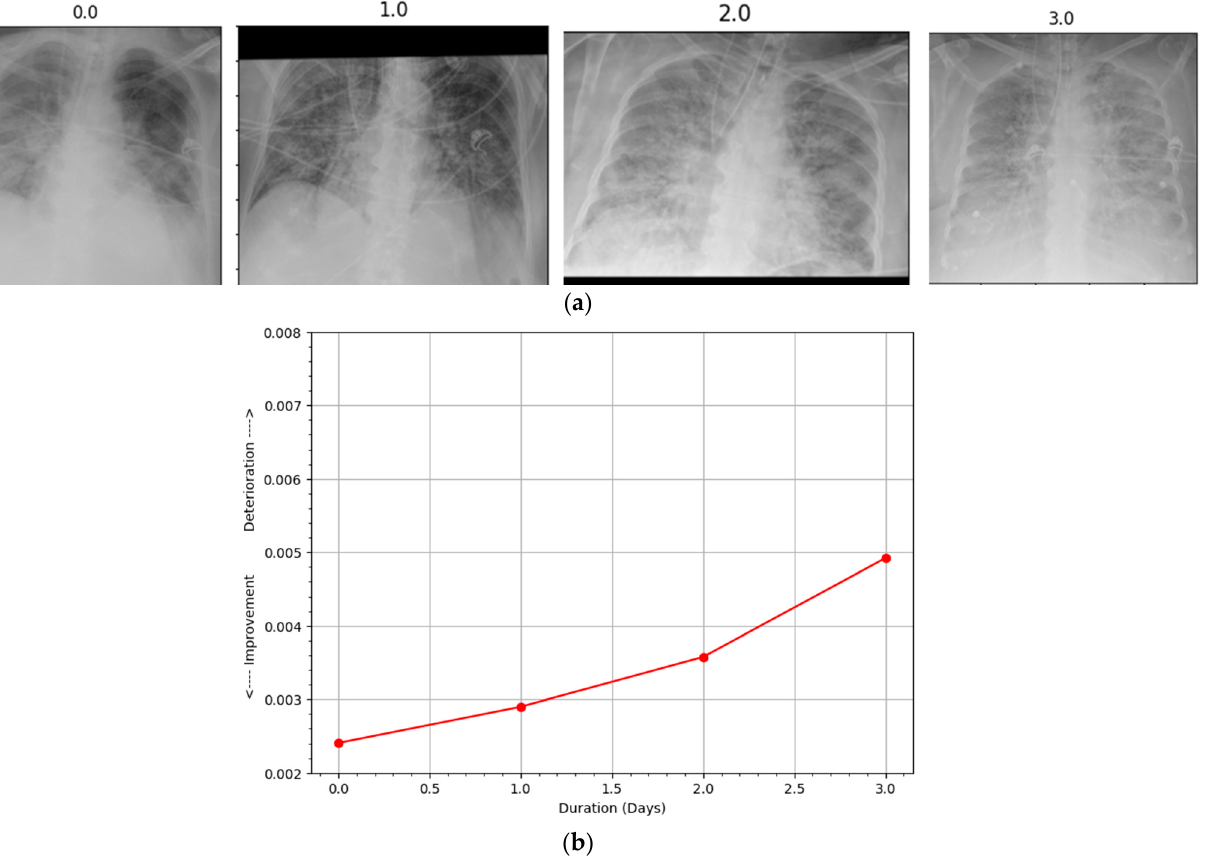
Figure 4. ( a ) Subsequent radiographs (178) showing deterioration, which is reflected in the ( b ) disease progression profile (represented by the red line). The patient did not survive the infection.